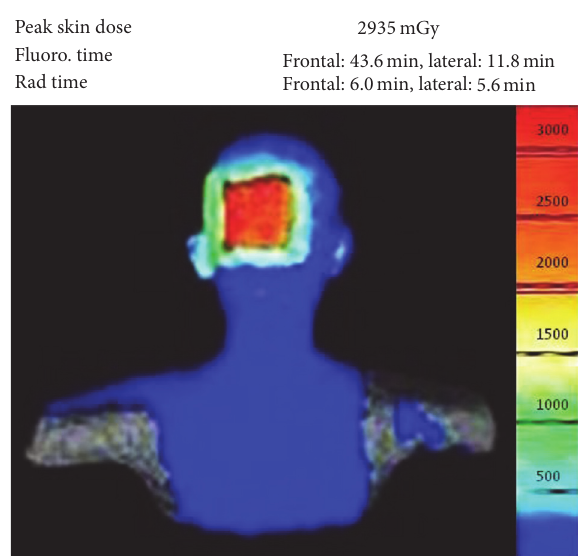
Figure 2: The rectangular shape of the radiation field in fluo- roscopy-guided endovascular embolization is consistent with alo- pecic area in our patient.